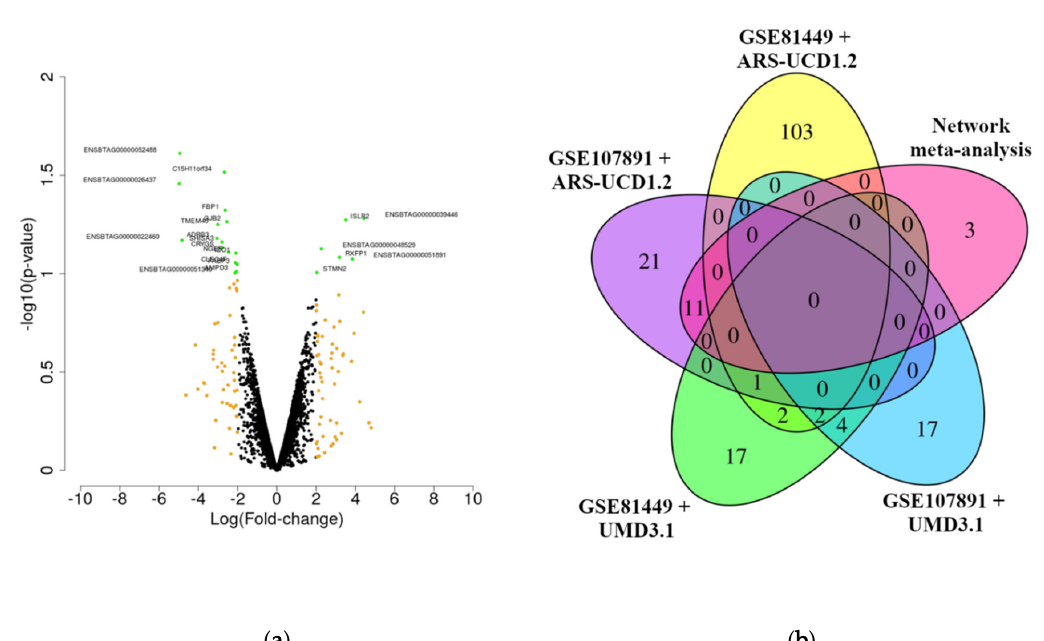
Figure 2. Volcano plot for the differentially expressed genes identified in the network meta-analysis (non-adjusted p-value < 0.1 and |log(fold-change)| > 2) (a) and Venn diagram comparing the results obtained in the different datasets of differentially expressed genes identified using different bovine reference genomes assemblies (b). In (a), the green dots represent differentially expressed genes identified using non-adjusted p-value < 0.1 and |log(fold-change)| > 2. The yellow dots represent differentially expressed genes identified using a |log(fold-change)| > 2. In (b), the differentially expressed genes identified in each dataset are represented in red (network meta-analysis), yellow (GSE107891 data set using ARS-UCD1.2 bovine reference genome), purple (GSE81449 data set using ARS-UCD1.2 bovine reference genome), dark green (GSE107891 data set using UMD 3.1 bovine reference genome; Moraes et al. (2018)), and blue (GSE81449 data set using UMD 3.1 bovine reference genome; Geary et al. (2016)).